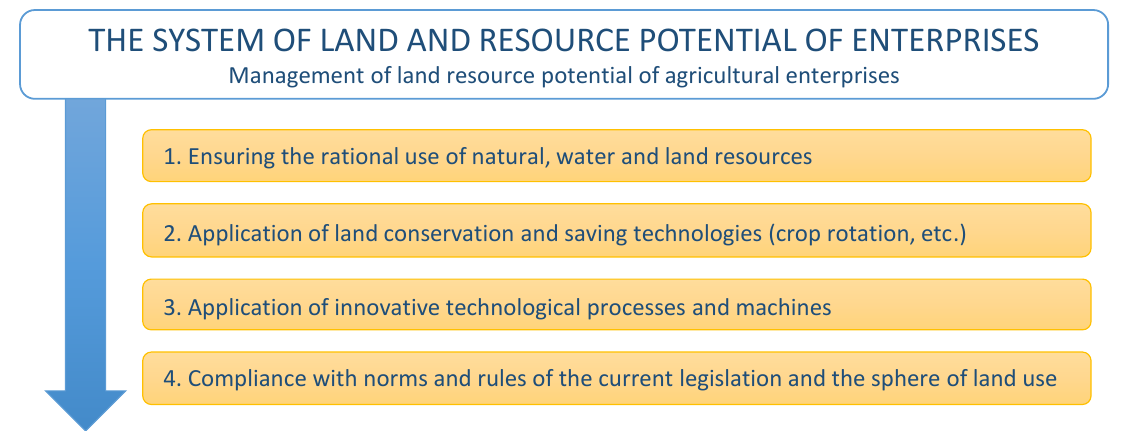
Figure 1. Scheme of formation of the system of land resource potential of enterprises